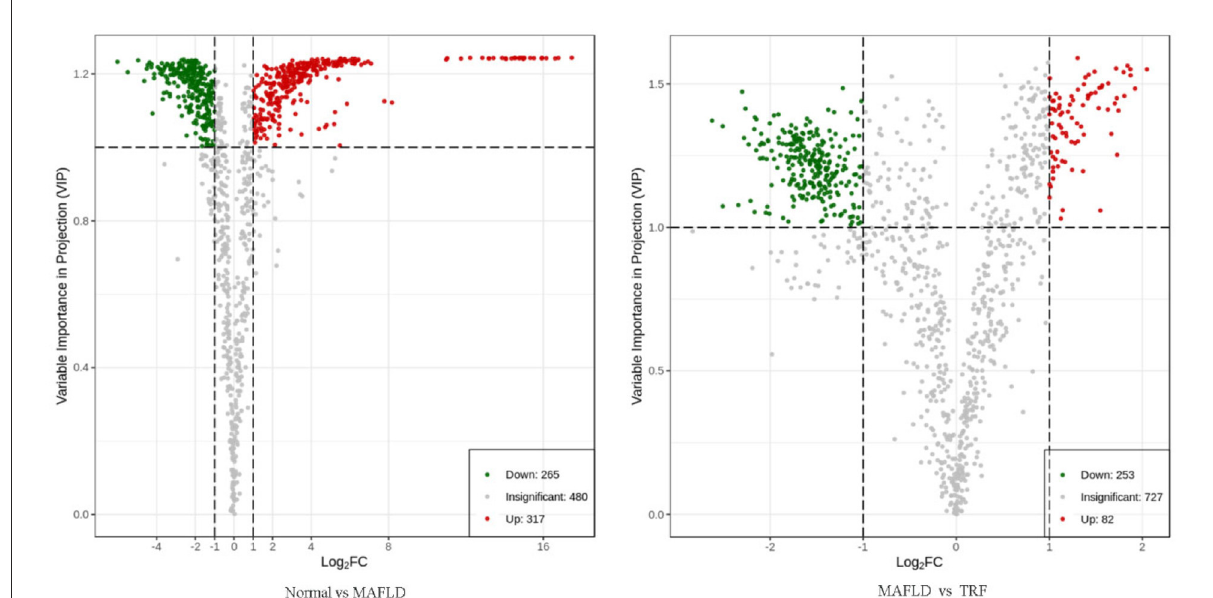
FIGURE7 Volcano plot of differential metabolites in liver tissue. Using FC ≥ 2 or ≤ 0.5 and VIP ≥ 1 as criteria, a group of lipids with significant differences were screened. Lipids with significant differences are shown as red (upregulated) or green (downregulated) dots, while gray dots indicate lipids with no significant differences. Normal, rats fed a normal diet ad libitum ; MAFLD (metabolic associated fatty liver disease), rats fed a high-fat diet ad libitum ; TRF (time-restricted feeding), rats fed high-fat diet (60 kcal% fat) strictly between 16:00 and 22:00 every